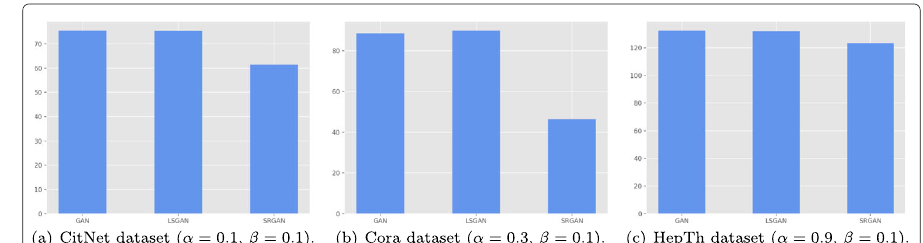
Fig. 3 Results of Q l distance on the three datasets in neighborhood preserving over the DDA methods 1